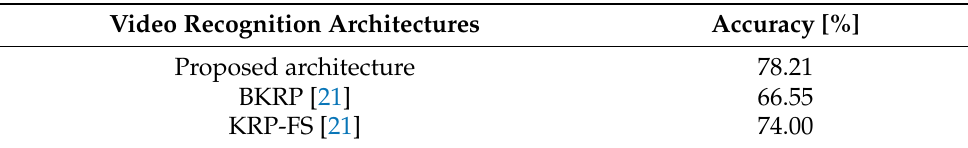
Table 9. Accuracy comparison of the proposed architecture with various neural network architectures using the MOD20